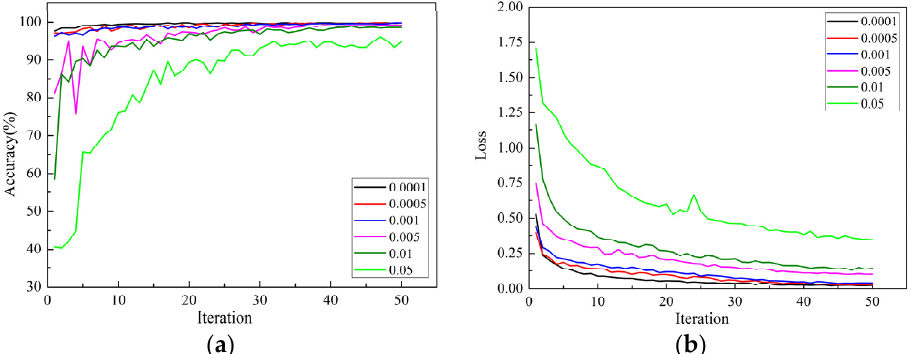
Figure 6. The influence of learning rate on the model training effect: ( a ) average accuracy curve of the models; ( b ) loss curve of the models. Table 3. The average accuracy of the model with different learning rates. Pre-Trained Models Accuracy on Validation Set(%) Accuracy on Test Set(%)